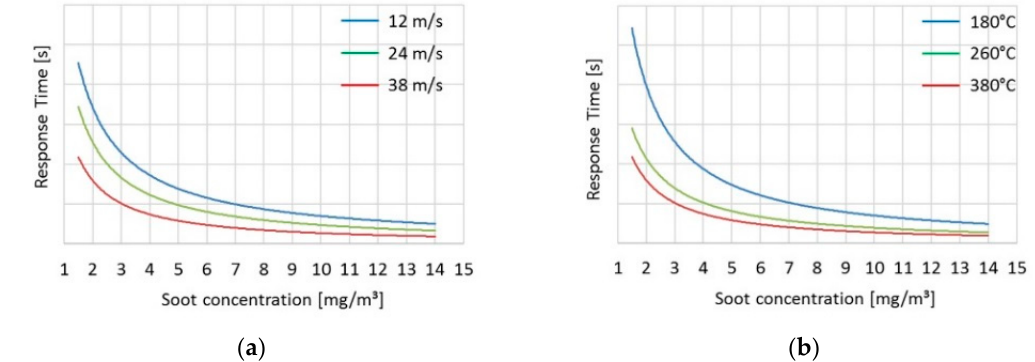
Figure 9. Example of performance of the statistical model over different levels of soot, velocity and temperature. ( a ) Sensor response time at 260°C for three exhaust gas velocity levels ( b ) Example of sensor response time at exhaust speed of 24 m/s for three exhaust gas temperature levels .